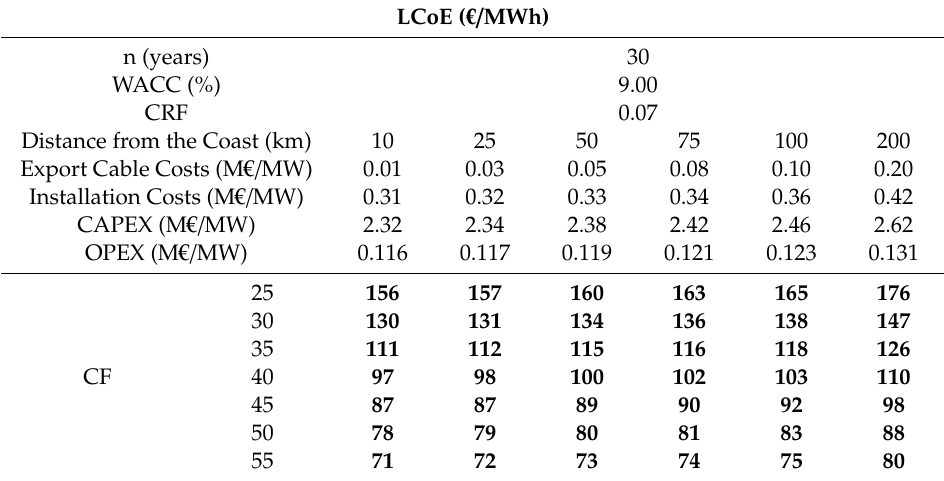
Table 4. LCoEs (in bold in the table) calculated as function of CAPEX, OPEX, and CF. WACC equal to 9%. LCoE ( € / MWh) n (years)